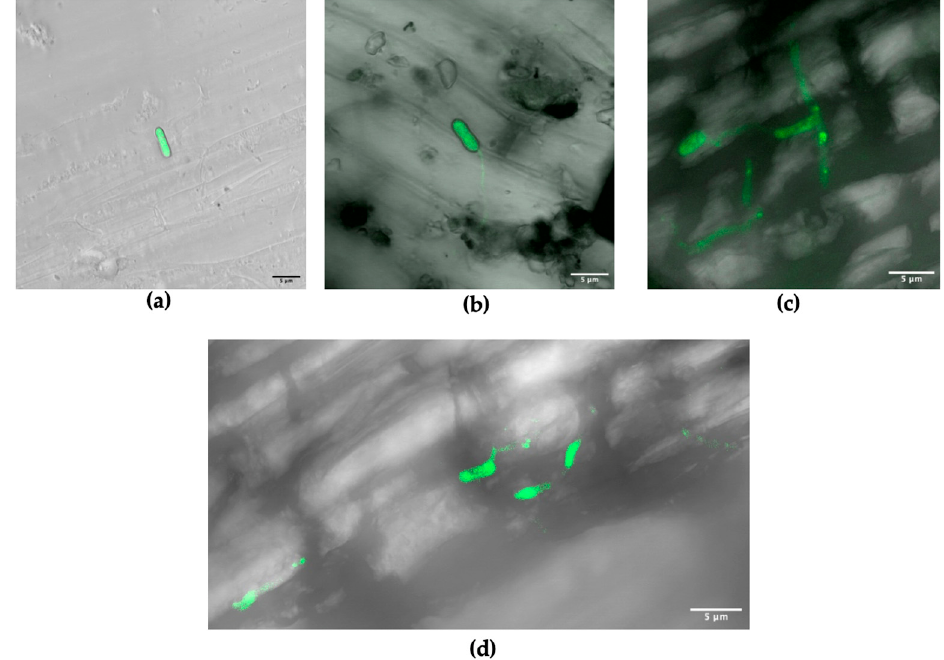
Figure 3. Confocal images of grapevine root association with M. robertsii ARSEF-2575-GFP expressing